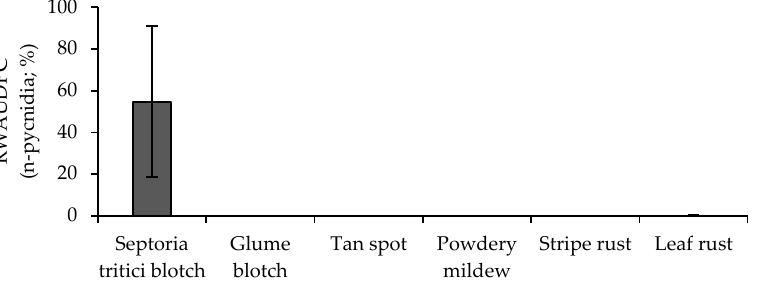
Figure 1. Occurrence of the major foliar diseases averaged from 1996 to 2021 at the trial location. RWAUDPC (x F−0 –x −6 = 14%) of Septoria tritici blotch and glume blotch as n-pycnidia. RWAUDPC (xF−0–x−6 = 14%) of tan spot, powdery mildew, stripe rust, and leaf rust as % affected leaf area from GS 30 to GS 77.